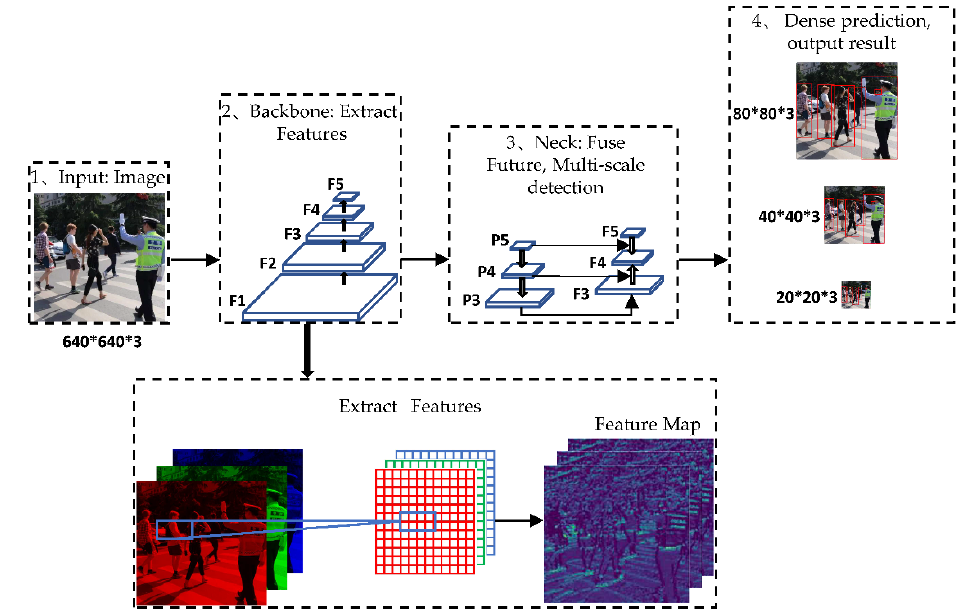
Figure 1. YOLOv5 algorithm structure